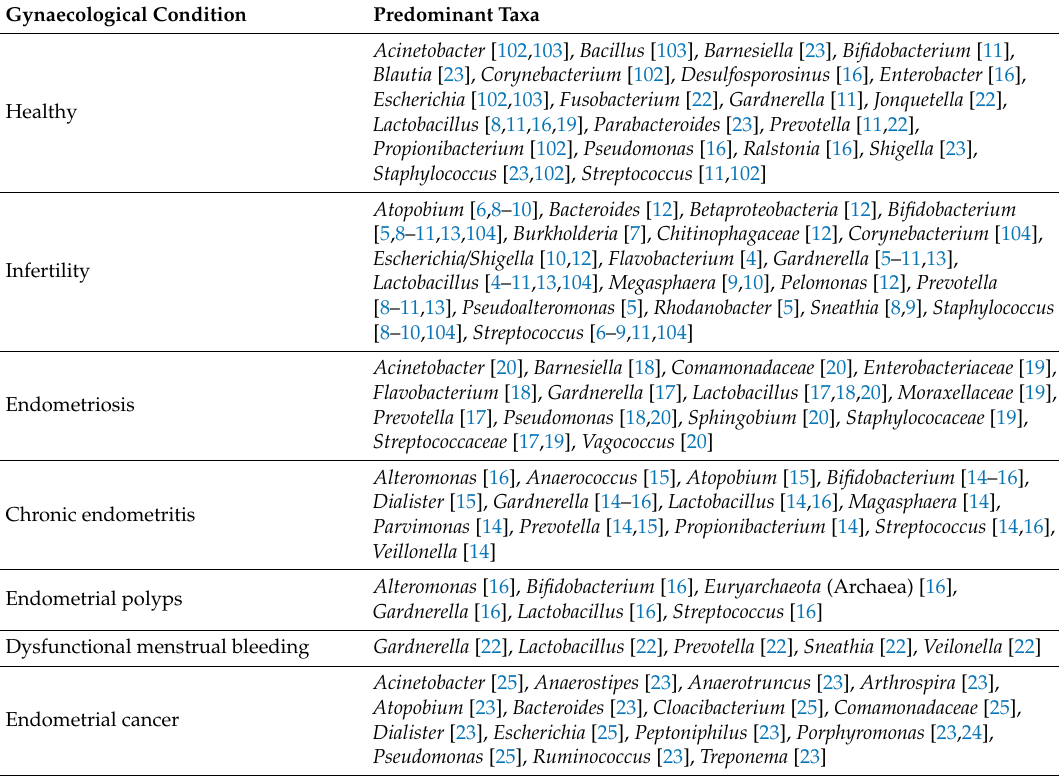
Table 1. Predominant taxa in endometrial microbiome for di ff erent gynaecological disorders revealed by next-generation sequencing